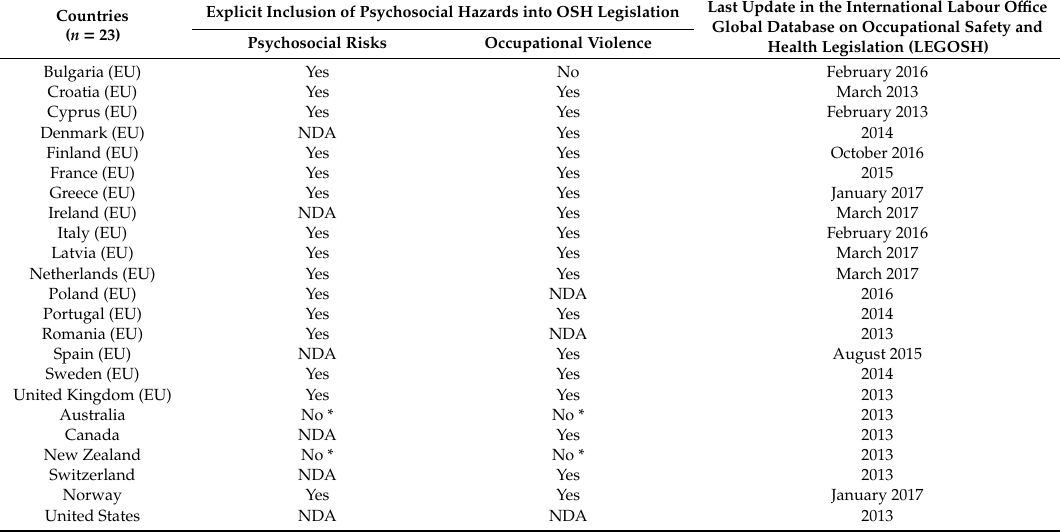
Table A1. Characteristics of OSH legislation concerning psychosocial hazards and workplace violence in developed countries. (EU = European